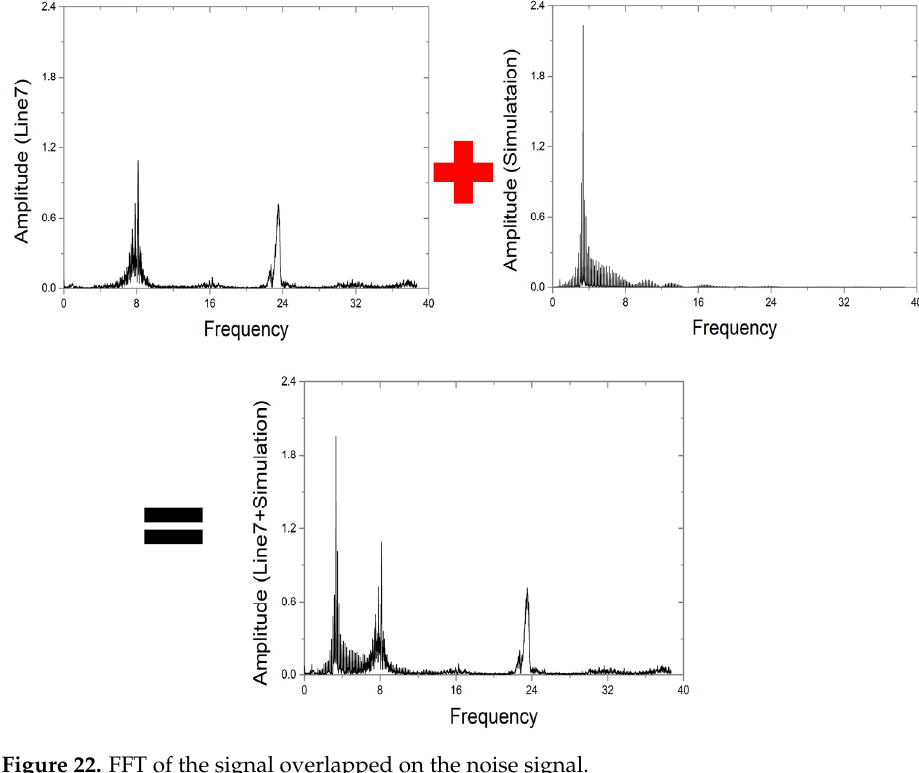
Figure 22. FFT of the signal overlapped on the noise signal.